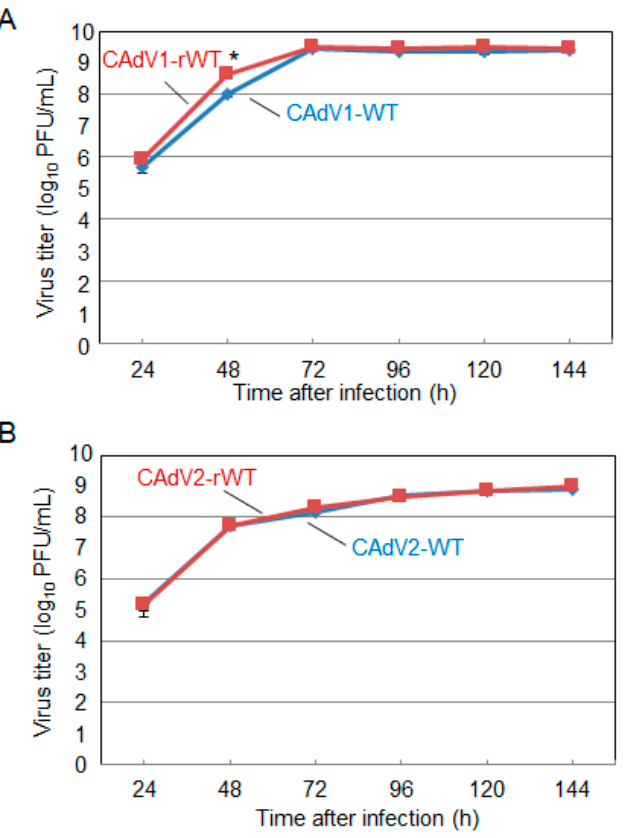
Figure 3. Growth kinetics of the wild-type (WT) and recombinant wild-type (rWT) viruses. MDCK cells were infected with ( A ) CAdV1-WT or CAdV1-rWT and ( B ) CAdV2-WT or CAdV2-rWT at a multiplicity of infection (MOI) of 0.01. The culture supernatants were collected at the indicated time points, and the viral titers were determined by plaque assay. The results were reported as the mean titer with standard deviations for three independent experiments. The asterisk indicates a significant difference ( p < 0.05 by Student’s t -test).